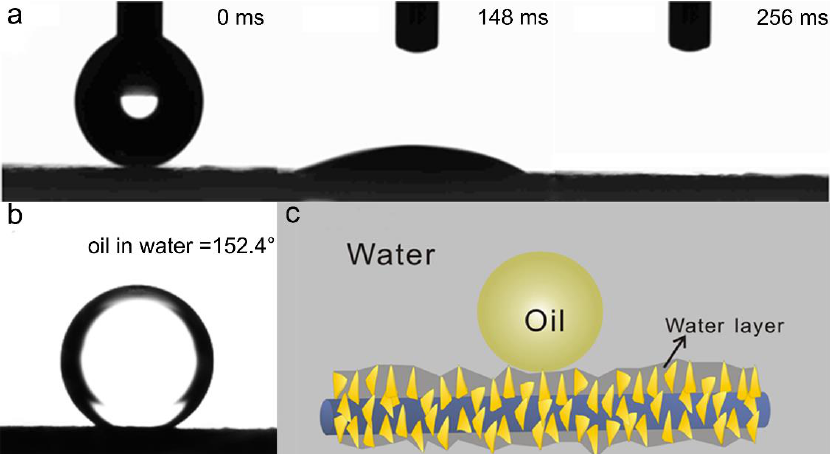
Figure 4. The wettability of the resulting P/CuO-nanosheet membrane: ( a ) the dynamic process of water droplets spreading on the membrane; ( b ) the underwater oil CA of the membrane; ( c ) the schematic diagram of the proposed water layer between the oil/water/solid interfaces.